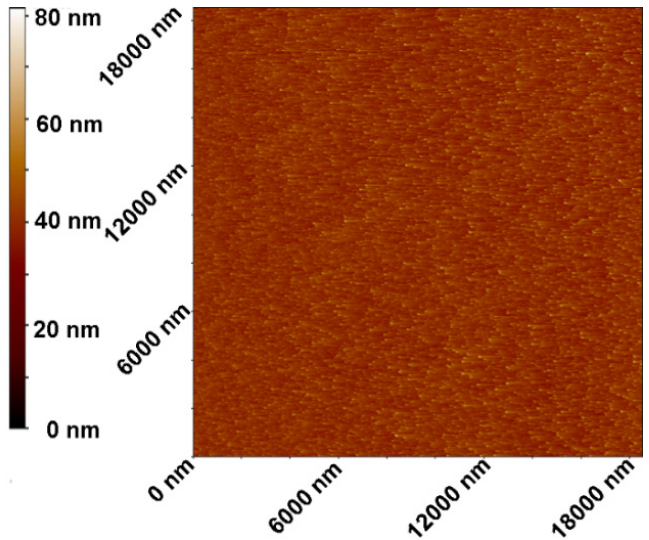
Figure 3. AFM images for the Cu200 catalysts after reduction.